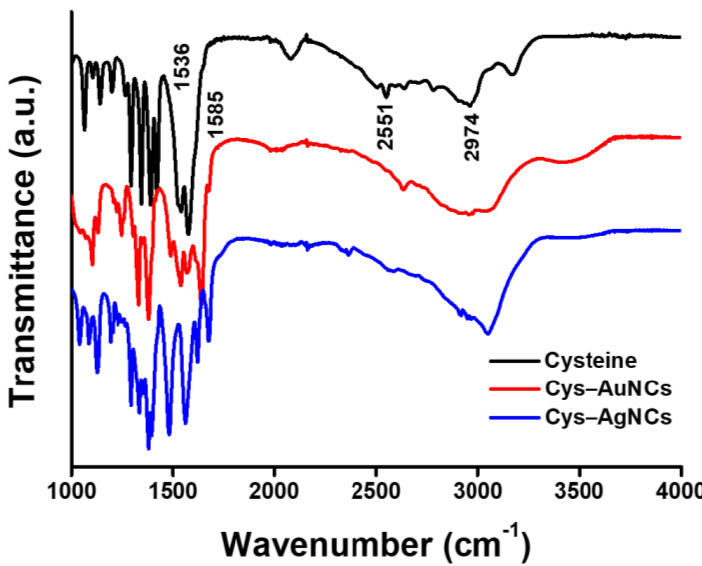
Figure 3. FTIR spectra of the cysteine (black), Cys–AuNCs (red), and Cys–AgNCs (blue).